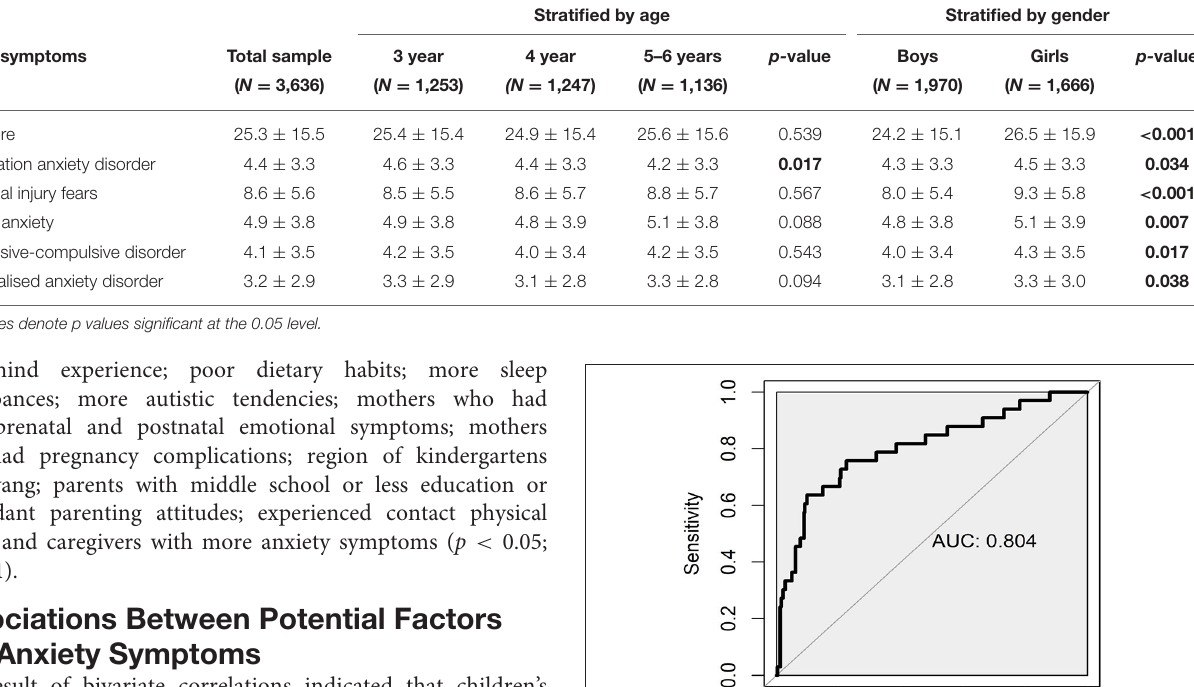
TABLE 2 | Anxiety symptoms scores (mean ± SD) for overall sample and subgroups of preschool children. Stratified by age Stratified by gender